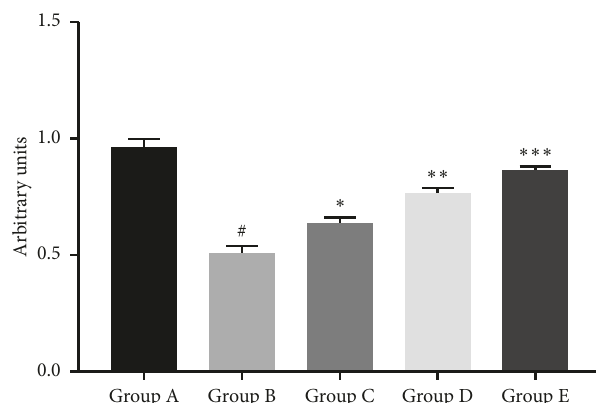
Figure 3: RT-PCR analysis of GLAST mRNA expression levels in retinal M¨uller cells. The cells were treated as described in Figure 1. # P 0 . 0001, compared with Group A (0mmHg additional pressure); (60mmHg additional pressure). Data from one experiment are shown as a representative of three studies performed under the same conditions. Group A: 0mmHg; Group B: 60mmHg; Group C: 60mmHg + 10 μ mol/L cyanin chloride; Group D: 60mmHg + 30 μ mol/L <